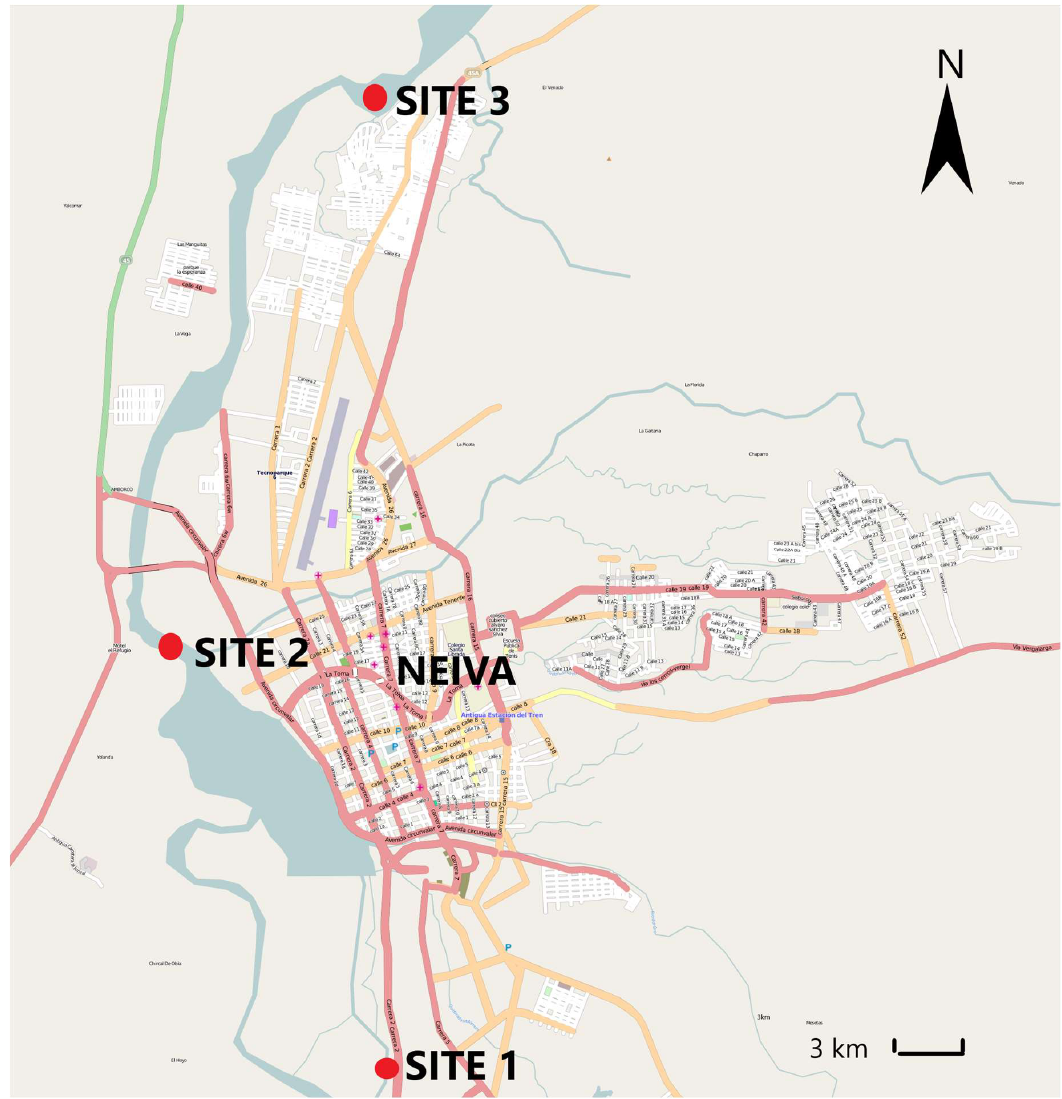
Figure 1. Map showing sampling sites in Neiva, Colombia, along the Magdalena River.